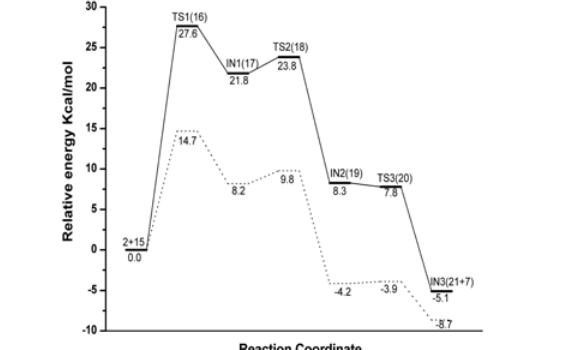
Figure 3. The potential energy profile for the channel 1 in reaction III computed with B3LYP/6-31G(d)//B3LYP/6-311++G(d,p) method. Solid and dashed lines represent free energies ( ∆ G ) and ZPE corrected energies ( ∆ E 298 reactants, respectively.